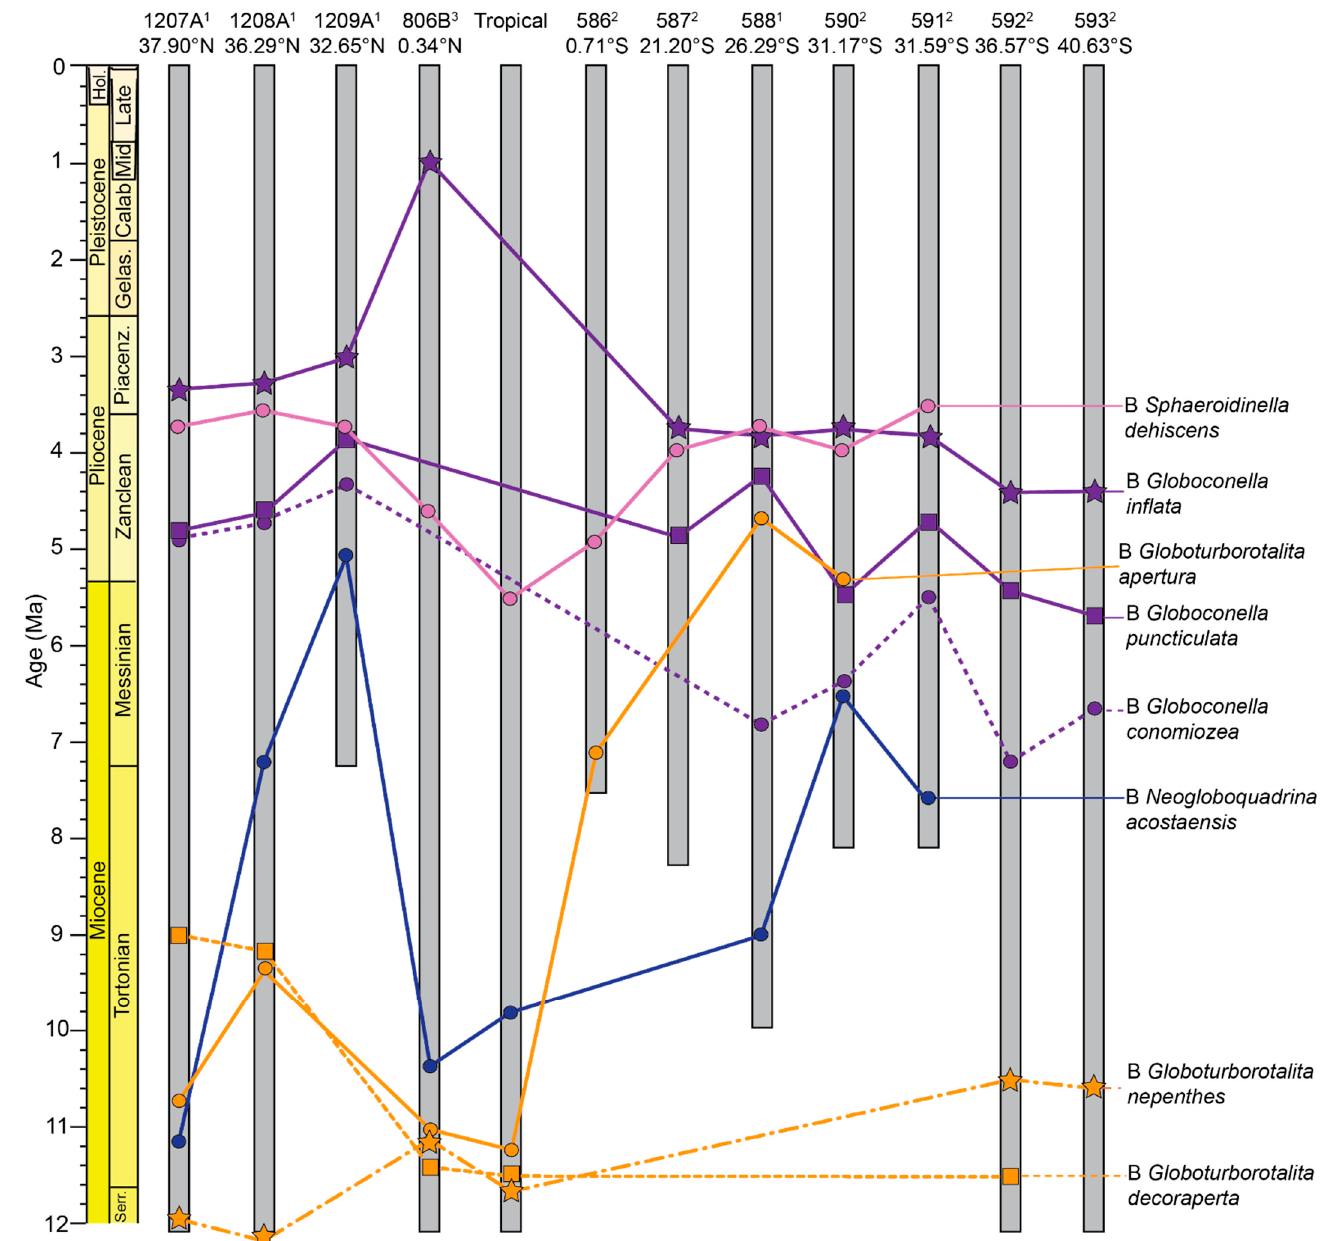
Figure 5. First occurrences of species used as primary and secondary datums in tropical-to-mid- latitude biostratigraphic zonations belonging to the genera Sphaeroidinella , Globoconella , Globoturborotalita , and Neogloboquadrina . Sites are ranked 1–3, as denoted by the superscript number beside each site number. A ranking of 1 indicates that the sites’ age model is based solely on magnetostratigraphy, a ranking of 2 indicates that the sites’ age model is a mix of magnetostratigraphy and biostratigraphy, and a ranking of 3 indicates that the sites’ age model is based solely on biostratigraphy (Supplementary Table S1).